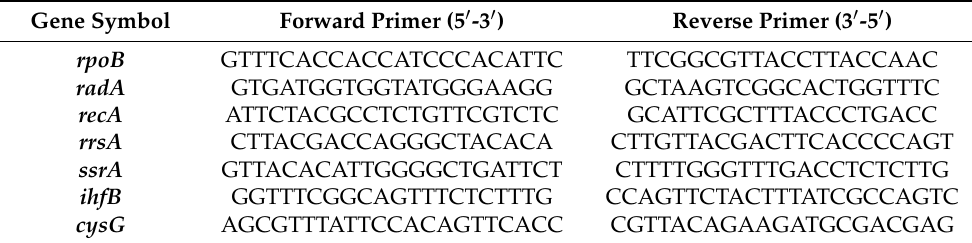
Table 2. Sequences of primers used in the